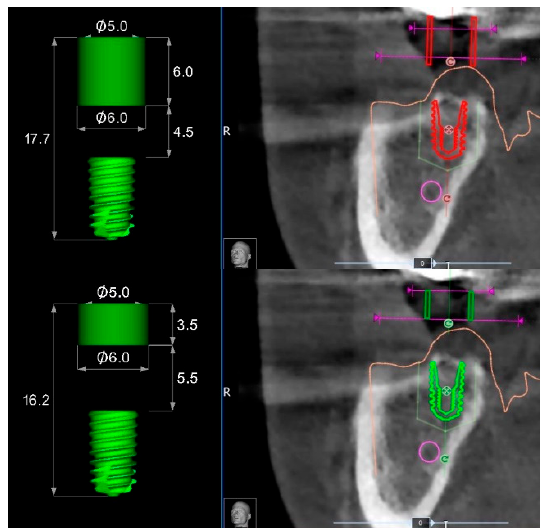
Figure 8. Differences between surgical templates with (lower) and without (upper) metallic Figure 8. Di ff erences between surgical templates with (lower) and without (upper) metallic sleeves for sleeves for a regular diameter implant of 7 mm length. a regular diameter implant of 7 mm